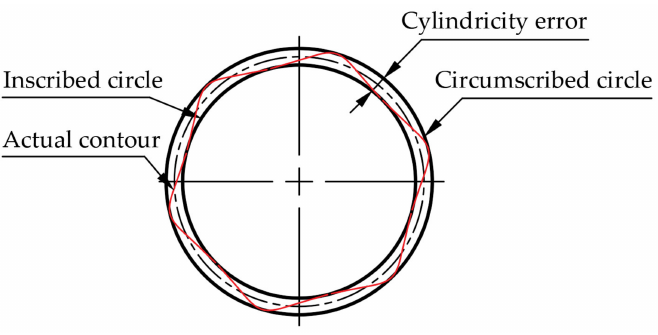
Figure 11. Schematic diagram of cylindricity cross section.